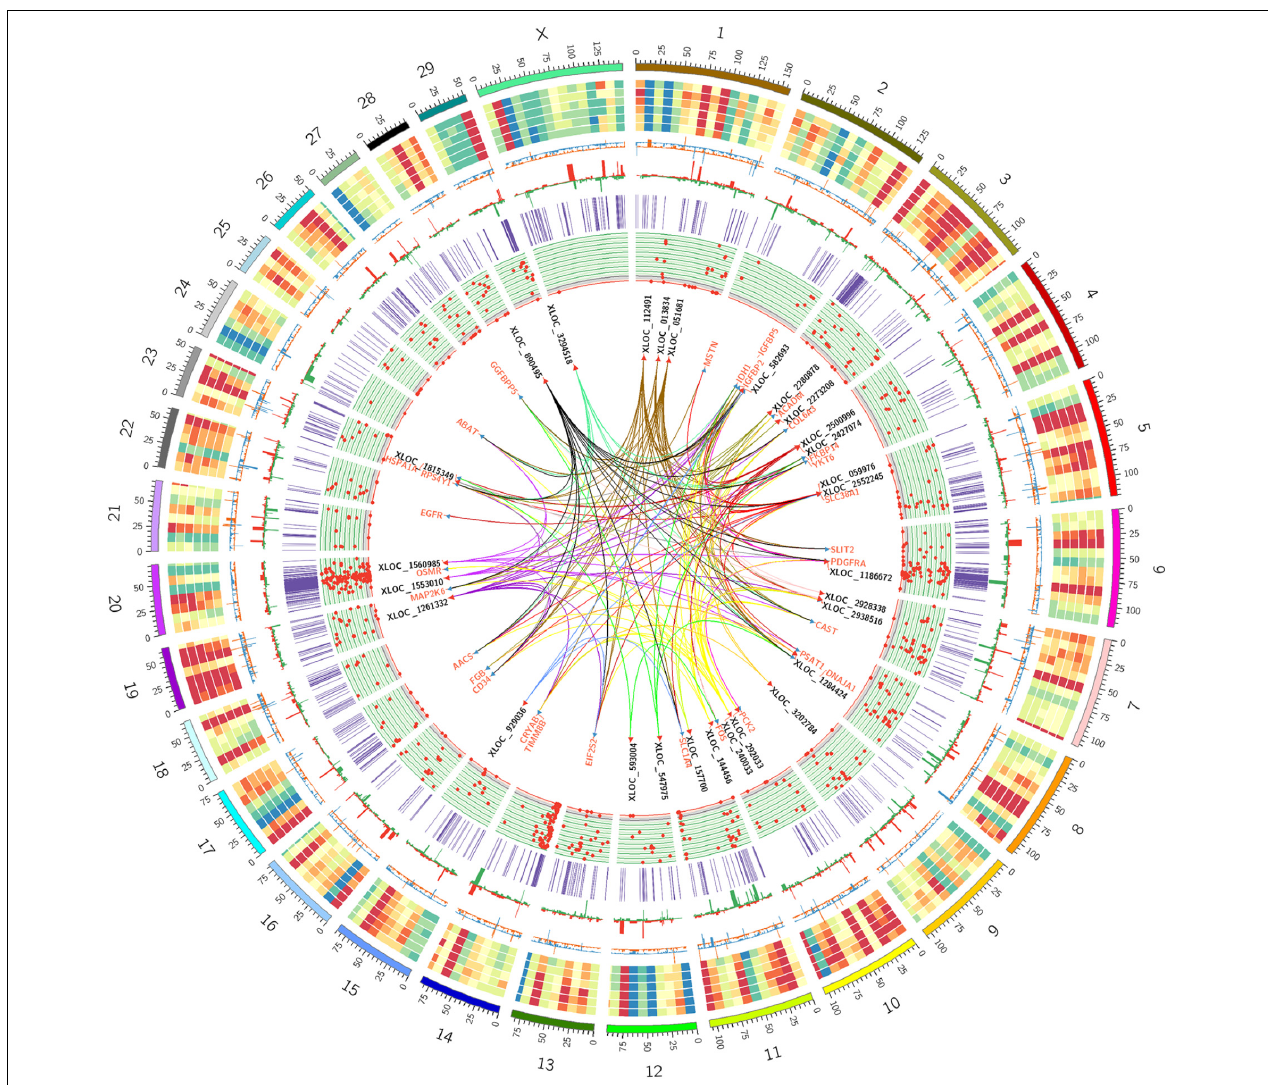
FIGURE 5 | Circos plot of the RNA-seq data, QTL databases and GWAS data. From outside to inside: chromosome number, reads coverage of six samples (three LP samples and three HP samples), mRNAs relative change between HP and LP (orange represents upregulation, blue represents downregulation), lncRNAs relative change between HP and LP (red represents upregulation, green represents downregulation), the location of milk protein QTLs from animal QTL database, the location of significant SNPs on milk protein traits from several previous research, the names of promising lncRNAs and mRNAs pairs associate with milk protein and the cis/trans target correlation between promising lncRNAs and mRNAs associate with milk